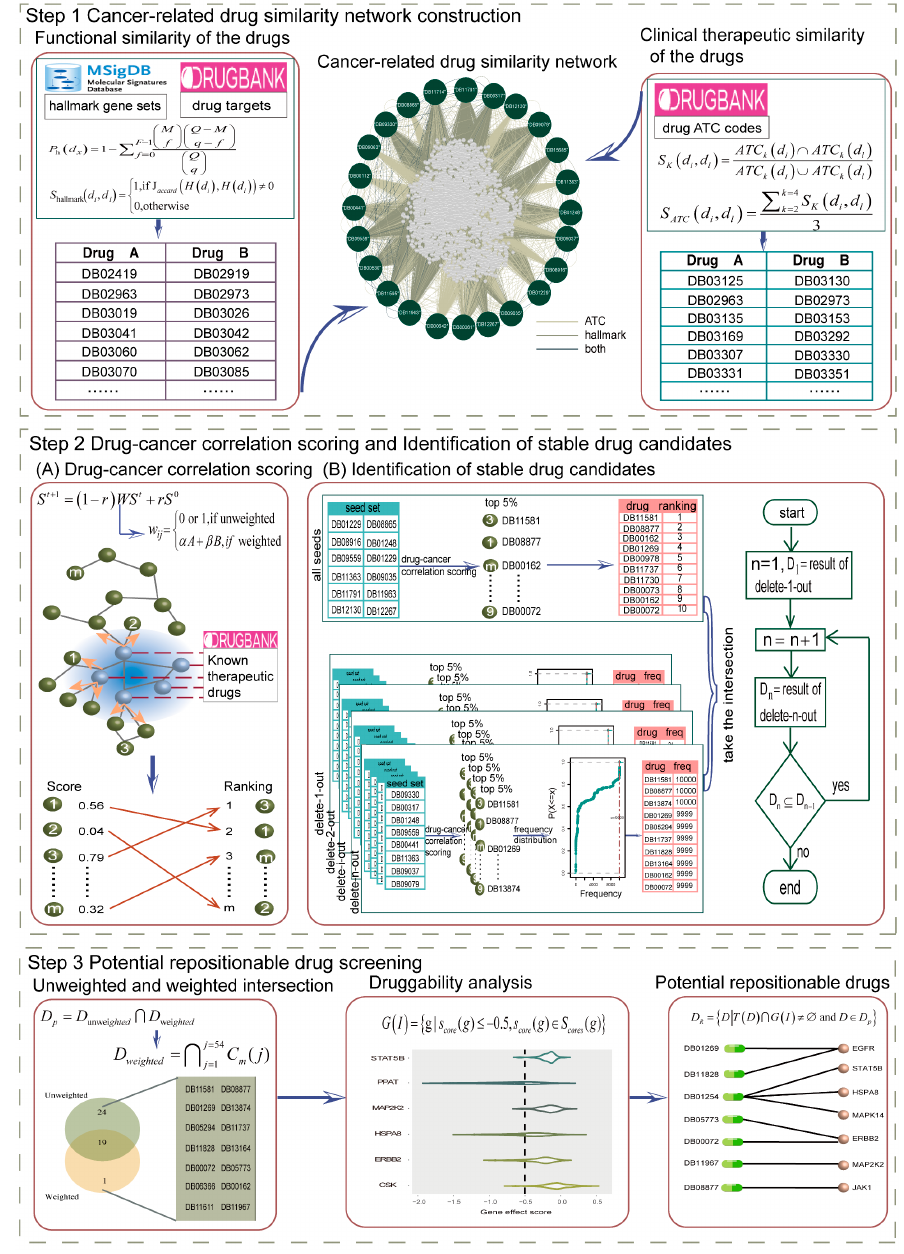
Figure 7. Flow chart of drug repurposing for specific cancer. Step 1, the functional similarity and